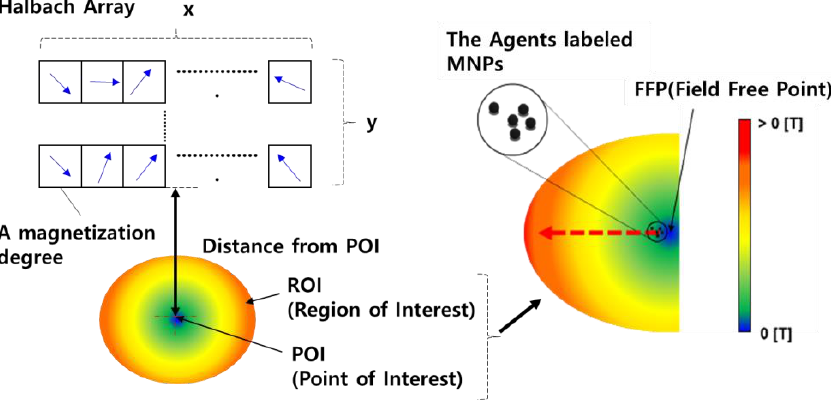
Figure 2. Fixation of MCTACs based on the Halbach array principle and field-free point.